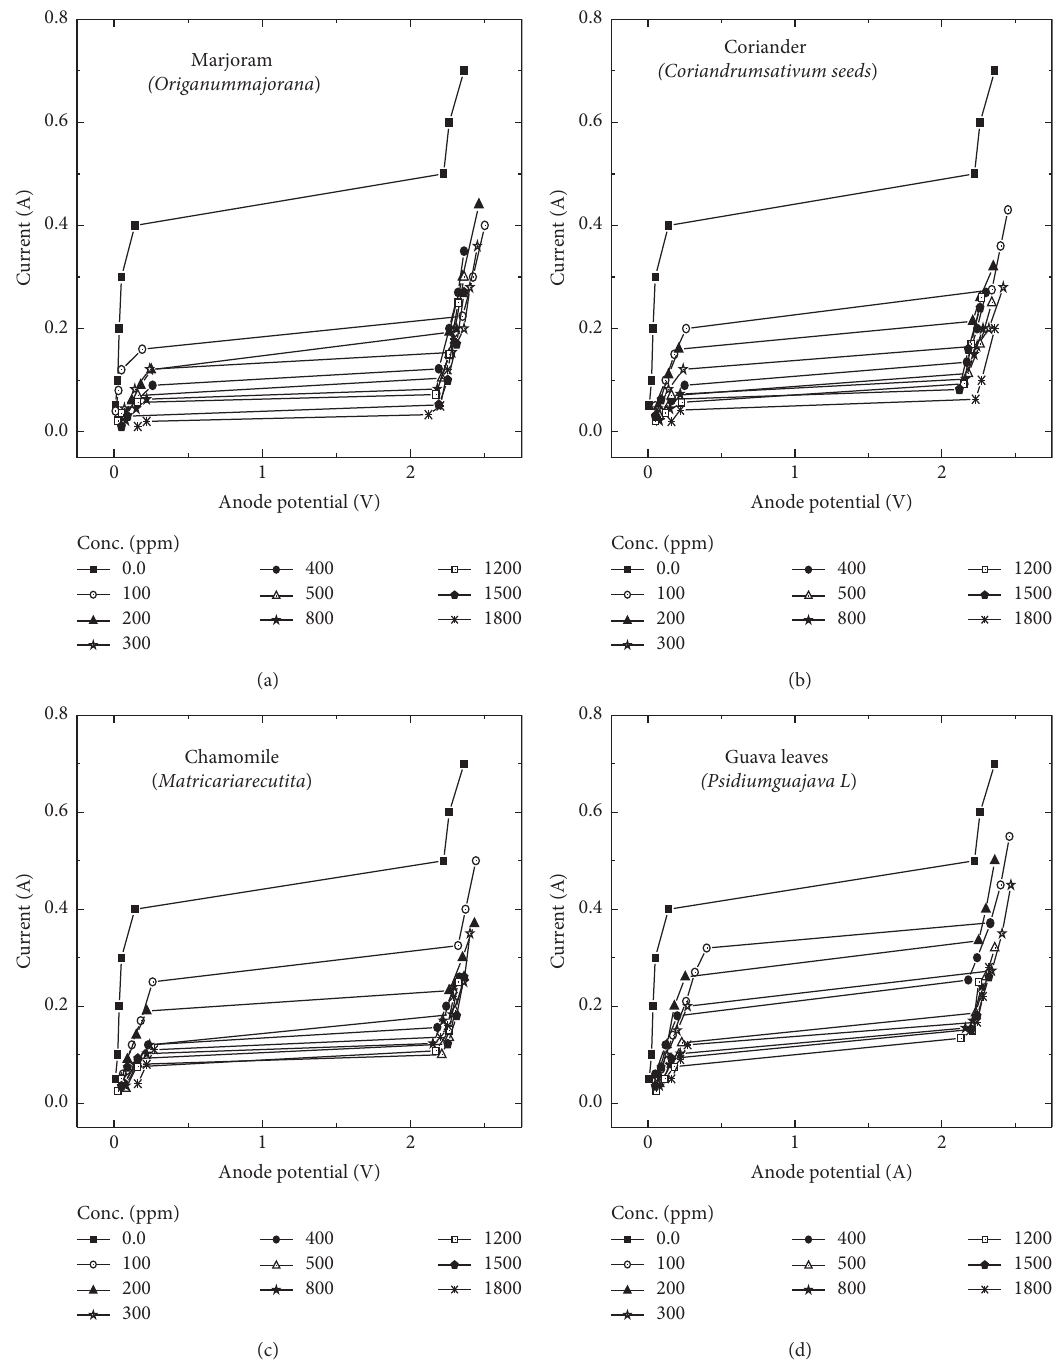
Figure 5: Characteristic polarization curve for C-steel electropolishing in 8M H (b) coriander seeds, (c) chamomile, and (d) guava leaves at